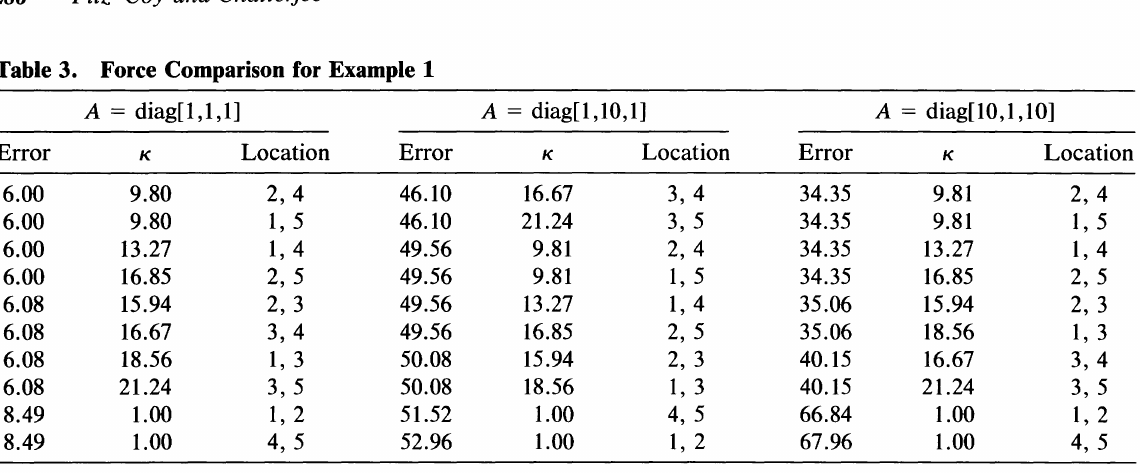
Table 3. Force Comparison for Example 1